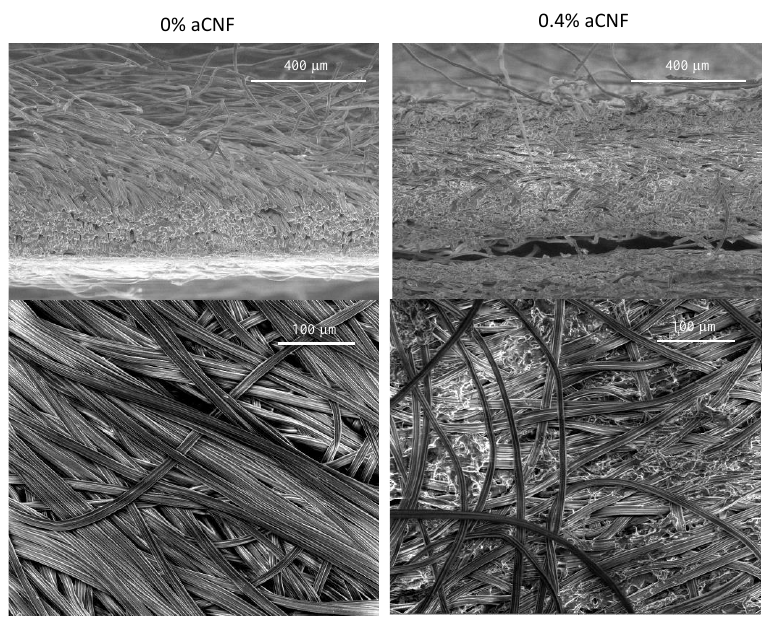
Figure 3. SEM micrographs of the cross section ( top ) and surface ( bottom ) of differently prepared individual (single-layered) fibrous membranes, namely, impregnated with 0.1 wt% quaternised cel- lulose nanofibrils (qCNF), with or without the addition of 0.4 wt% amino-hydrophobised CNF (aCNF).